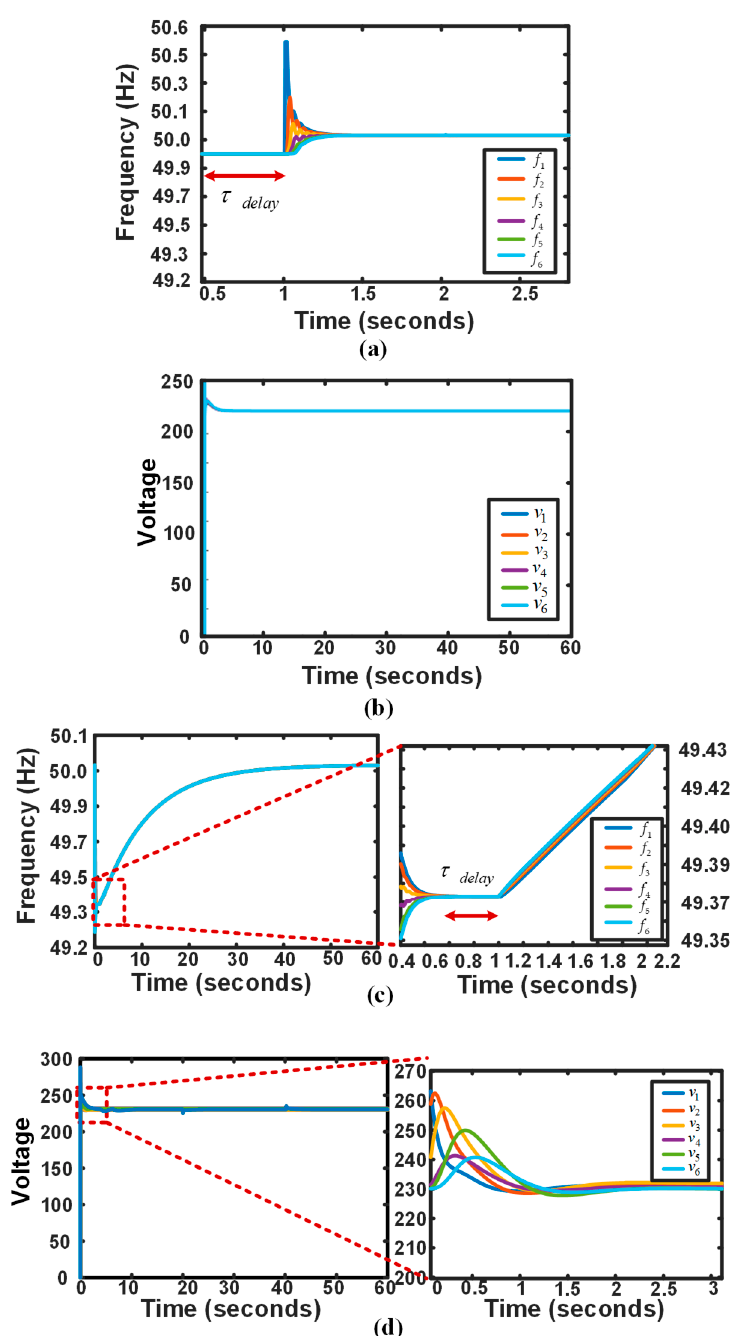
Figure 8. ( a ) Frequency regulation with proposed scheme ( b ) Voltage regulation with proposed scheme ( c ) Frequency regulation with conventional observer-based control ( d ) Voltage regulation with conventional observer-based